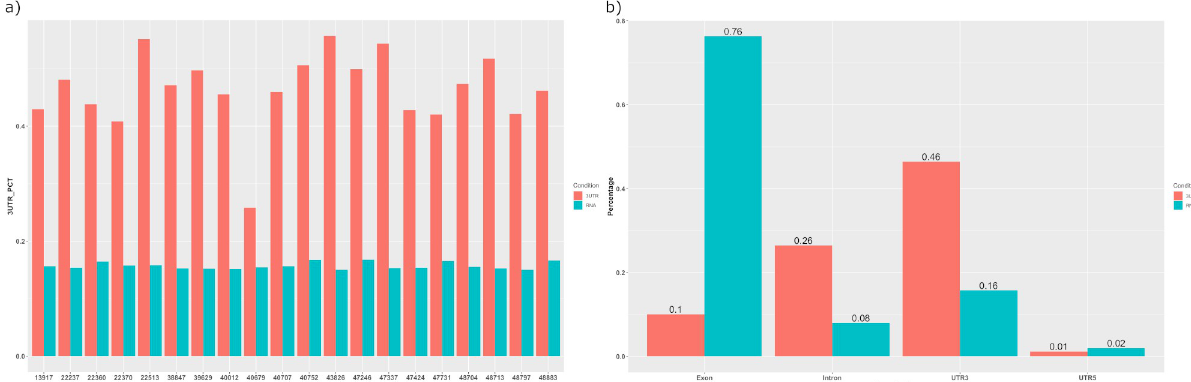
Fig 3. Read distribution results of RSeQC. a) 3’ UTR percentage (3UTR_PCT) of each sample; b) read distribution of gene structure shown in average percentage.